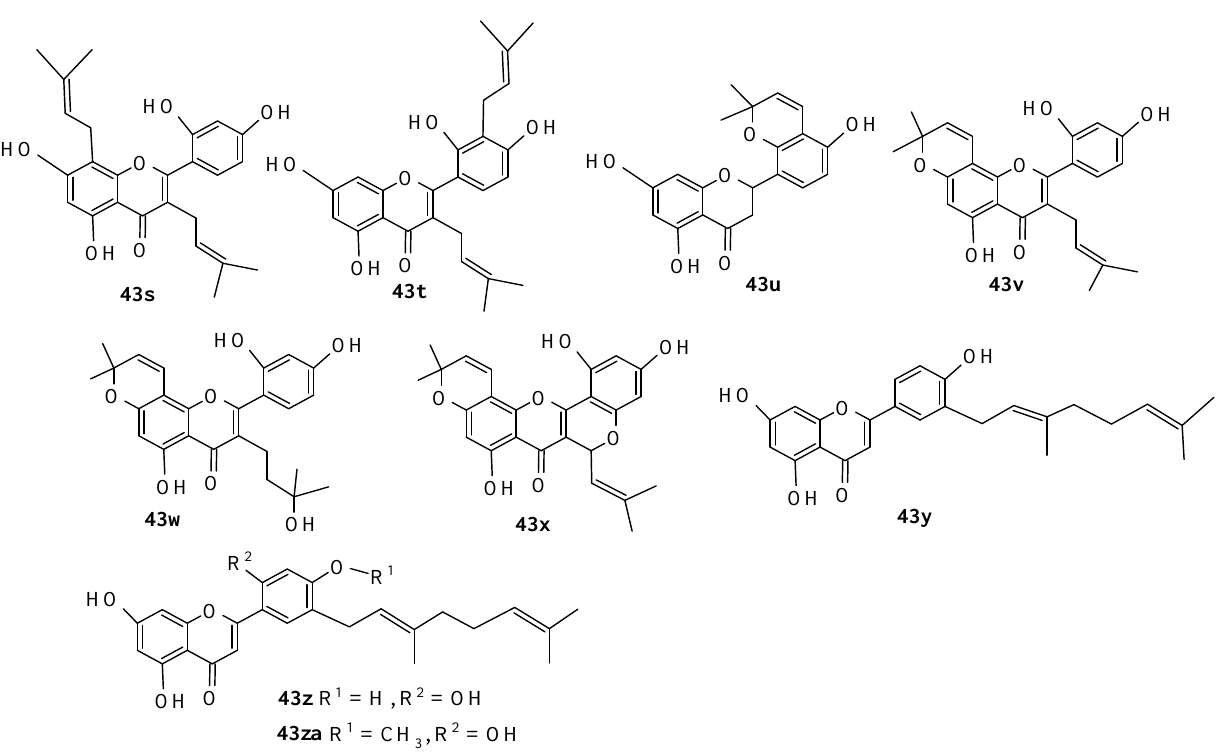
Figure 11. Chemical structures of flavonoids isolated from the root bark of Morus alba L. [43]. Lin et al. further evaluated the anti-inflammatory and antioxidative activities of mul- berry ( M. alba L.) leaf flavonoids. Initially, different ethanol concentration (30%, 50%, and 75%)-based extracts were prepared to obtain flavonoid-rich extracts. These extracts inhib- ited the production of nitric oxide (NO), prostaglandin E2 (PGE 2 ), inducible nitric oxide synthase (iNOS), cyclooxygenase-2 (COX-2), and inflammatory cytokines in lipopolysac- charide (LPS)-induced RAW 264.7 cells. All extracts increased the antioxidative capacity by decreasing the reactive oxygen species (ROS) production and the scavenging of 2,2- diphenyl-1-picrylhydrazyl (DPPH) free radicals and improving the metal ion chelating